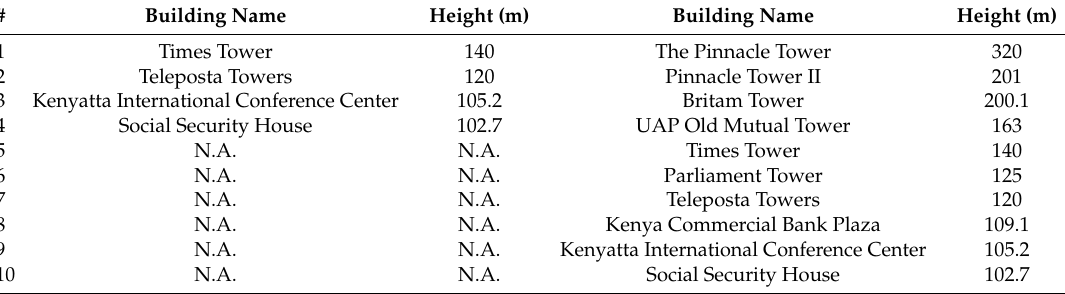
Figure 22. Nairobi in 2000 and 2020. Table 32. Nairobi’s 10 tallest skyscrapers in 2000 and 2020.